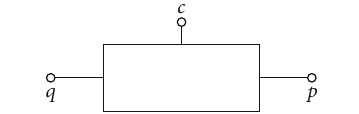
Figure 3: Schematic diagram of a gear pair